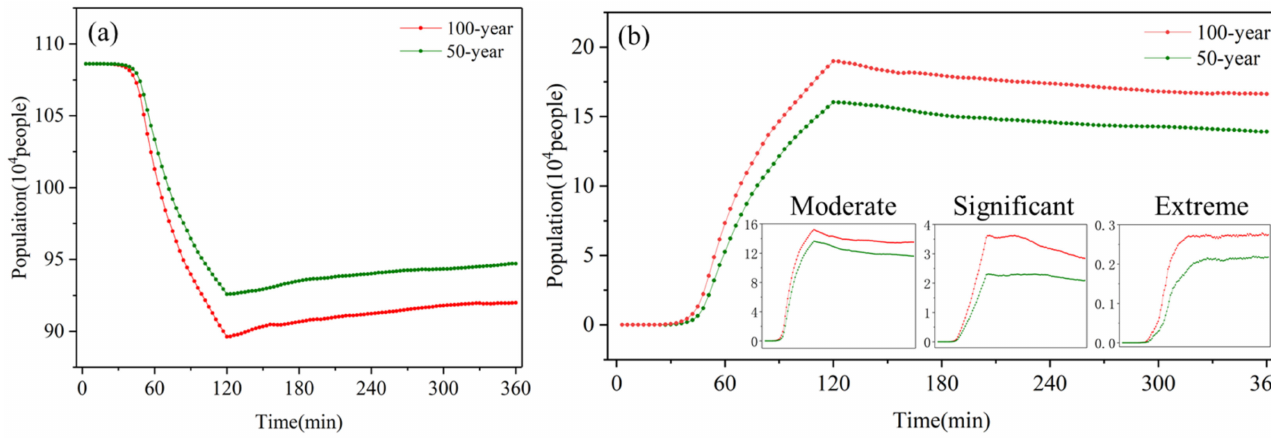
Figure 13. Dynamic changes of potential flood-affected population and flood-affected population. ( a ) potential flood-affected population and ( b ) flood-affected